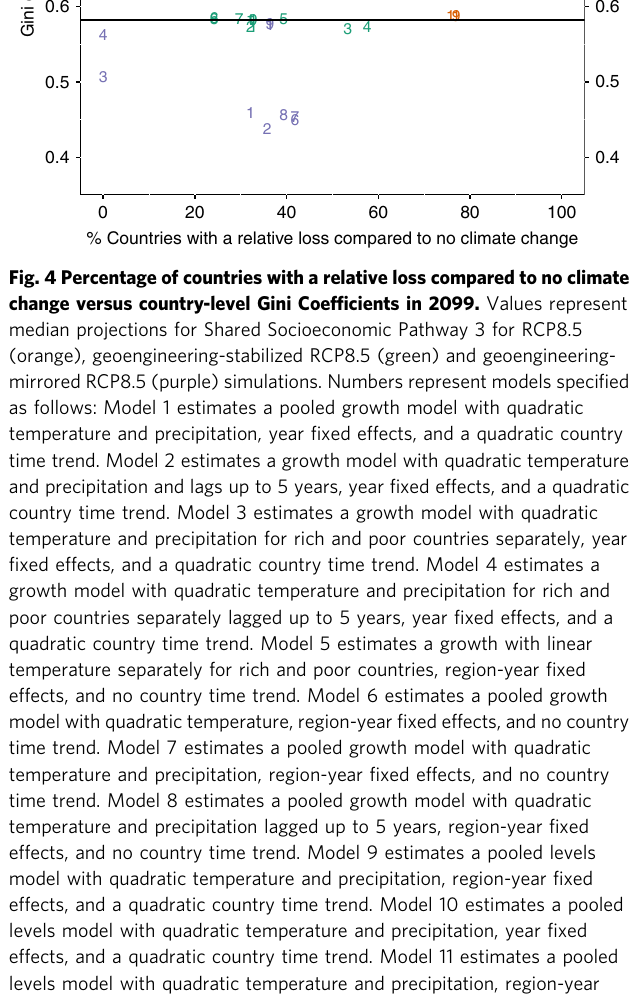
(Supplementary Table 2) to project GDP per capita for each climate model individually. Climate variable output from individual model ensemble members span a broader range of temperature and precipitation responses, which translates into greater uncertainty in global economic impacts (Supplementary Fig. 8. However, across projections for each of the climate models, our fi nding that solar geoengineering reduces global income